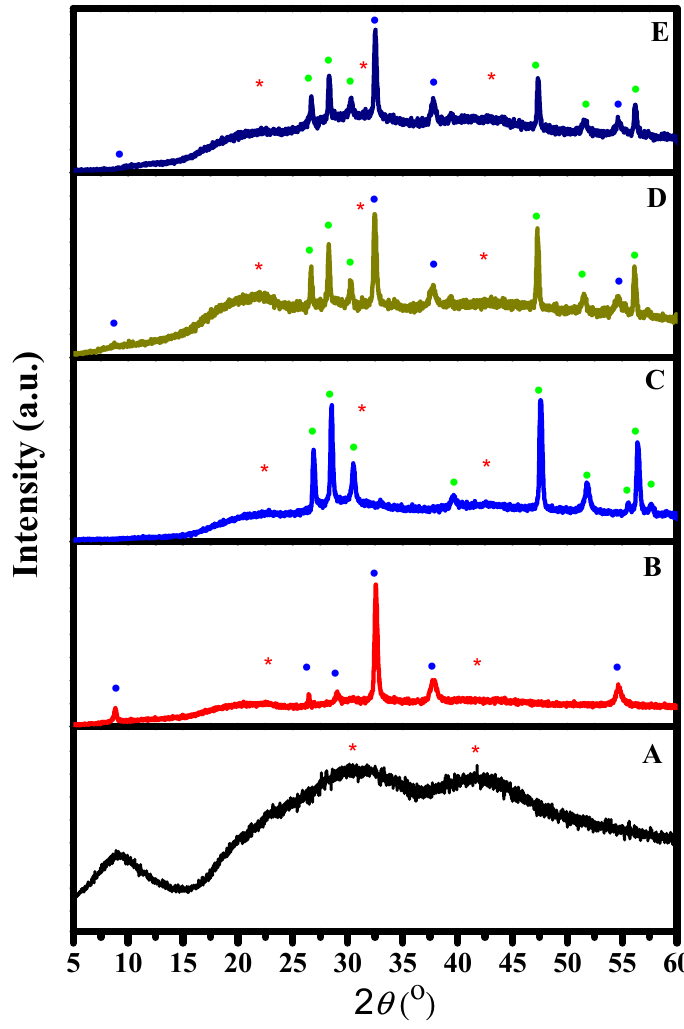
Figure 1. X-ray diffraction (XRD) pattern of different composites ( A ) CA, ( B ) Ag 2 O/CA, ( C ) ZnS/CA, ( D ) Ag 2 O/ZnS/CA, and ( E ) Ag 2 O/ZnS/GO/CA: ( • blue dot) Ag 2 O, ( • green dot) ZnS, and ( * ) CA.